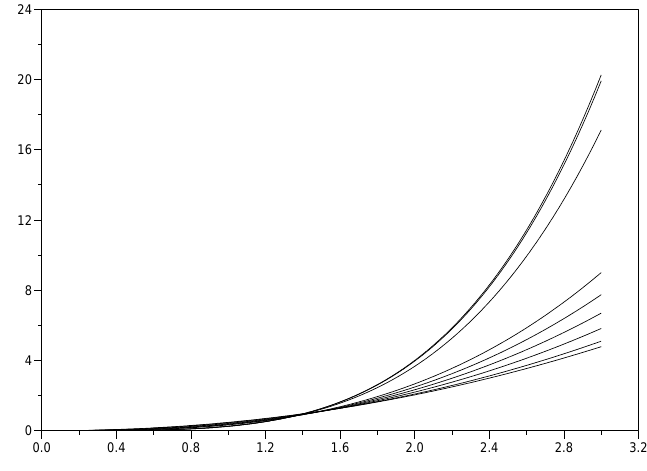
(cid:82) t B H ( s ) ds , given by (19), as a function of t for various 0